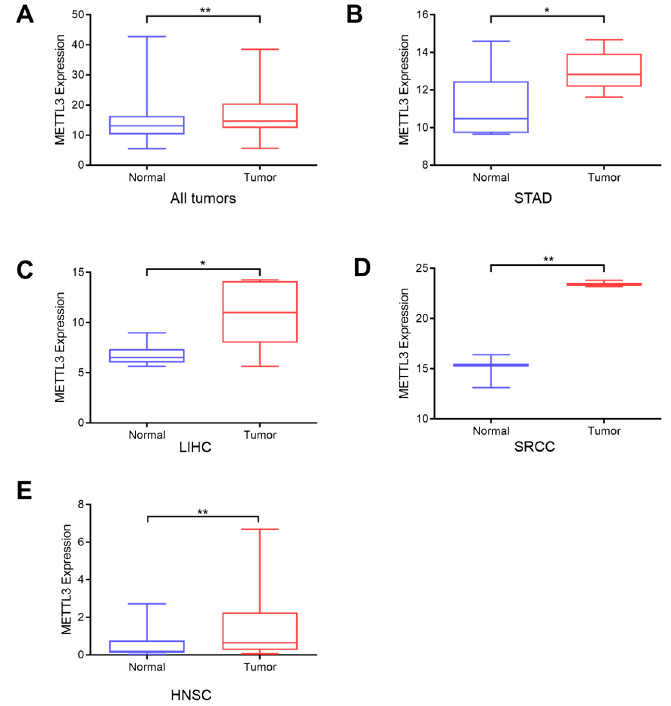
Figure 4. ( A ) Elevated expression levels of METTL3 in pan-cancer tumor tissues in GSE87410 (** p < 0.01). ( B – D ) Elevated expression levels of METTL3 in STAD, LIHC and SRCC tissues included in the GSE87410 dataset (* p < 0.05, ** p < 0.01). ( E ) Elevated mRNA levels of METTL3 in HNSC tissues in our collected tissues (** p < 0.01).